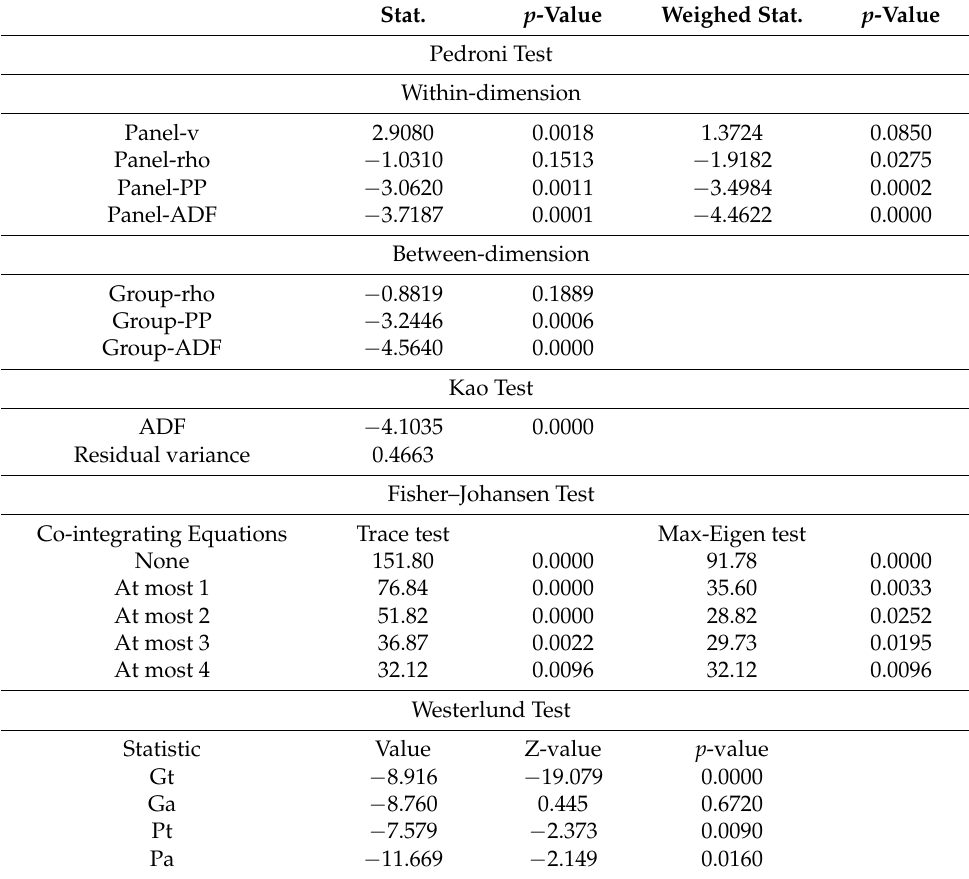
Table A3. Panel cointegration: LNGC it as the dependent